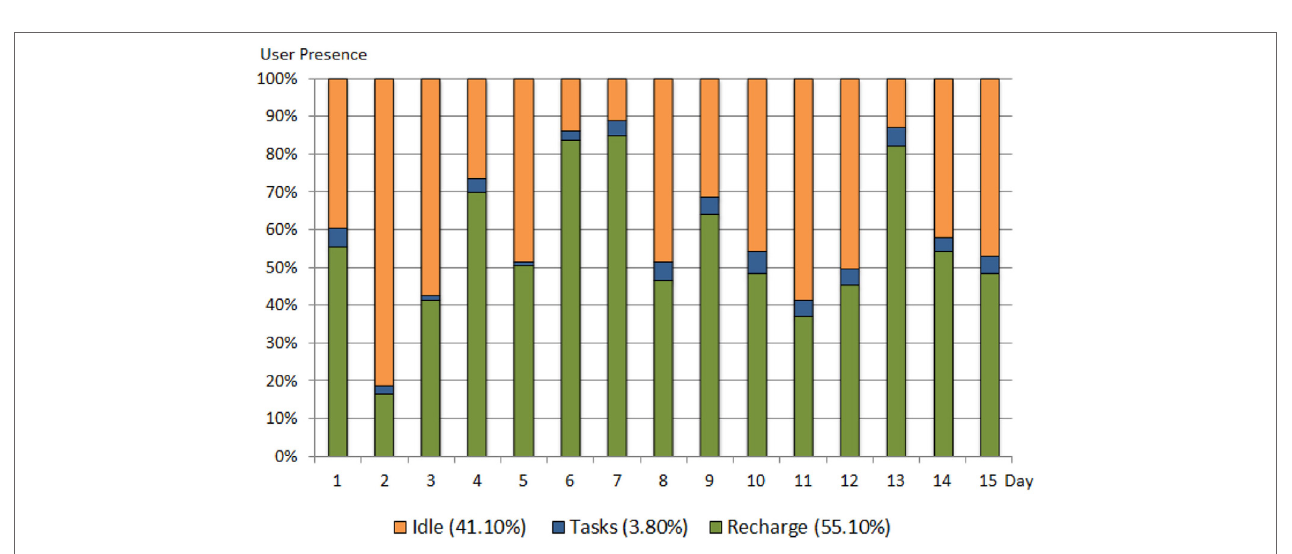
FigUre 3 | Users at the work desks with the robot (not the actual participants in the study). Participants have written consent for their picture to be published.